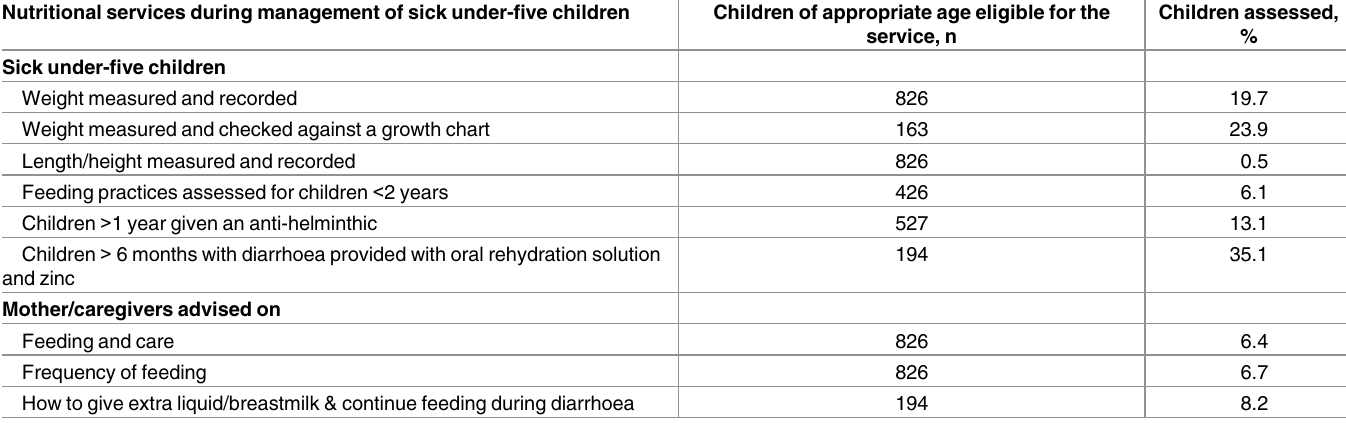
Table 6. Assessment of nutritional servicesduring management of sick under-five children as observed during serviceprovision. Nutritional services during management of sick under-five children